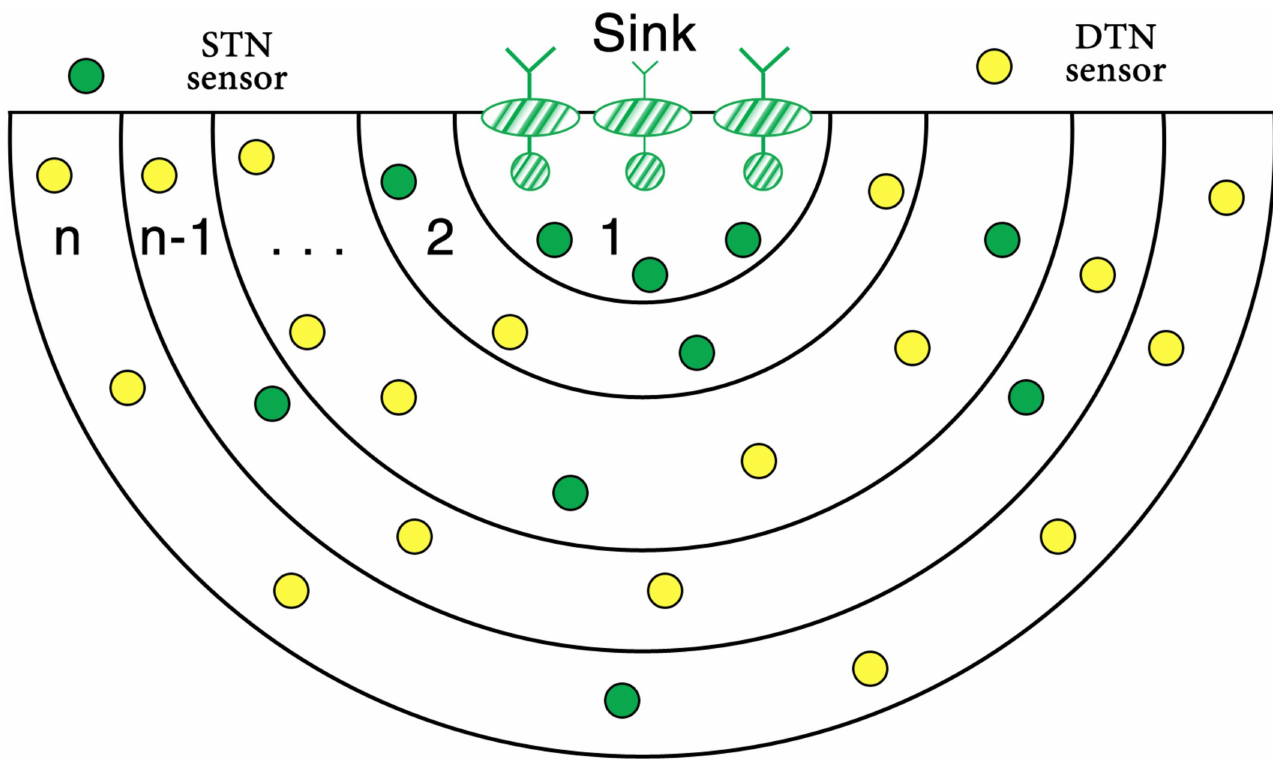
Fig 2. Layering structure in TORA at node localization